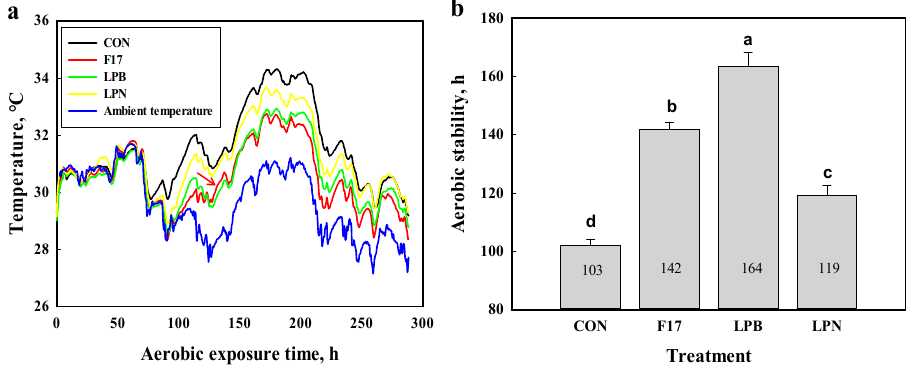
Figure 1. Effects of bacterial inoculants on aerobic stability of alfalfa silage. ( a ), temperature change during the aerobic phase; ( b ), aerobic stability of alfalfa silage treated without or with different inoculants. Treatment: CON, control, no additive; F17, Lactobacillus delbrueckii F17; LPB, Lactobacillus plantarum (BNCC 336943); LPN, Lactobacillus plantarum MTD/1 (NCIMB 40027). Bars with different lowercase letters differed at p < 0.05 (n = 4, error bars indicate standard error of the mean).